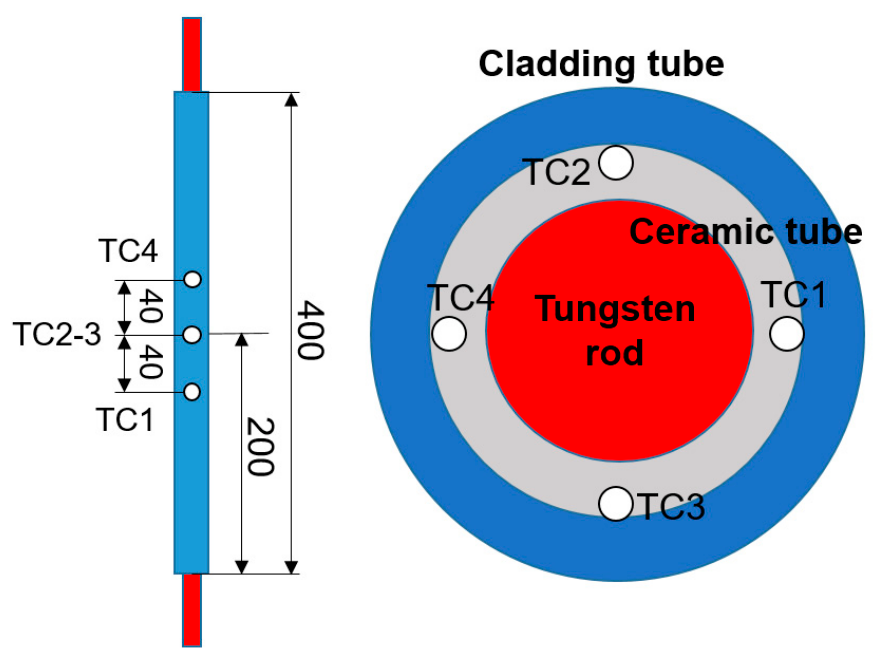
Figure 2. Schematic of test specimen and TC location.